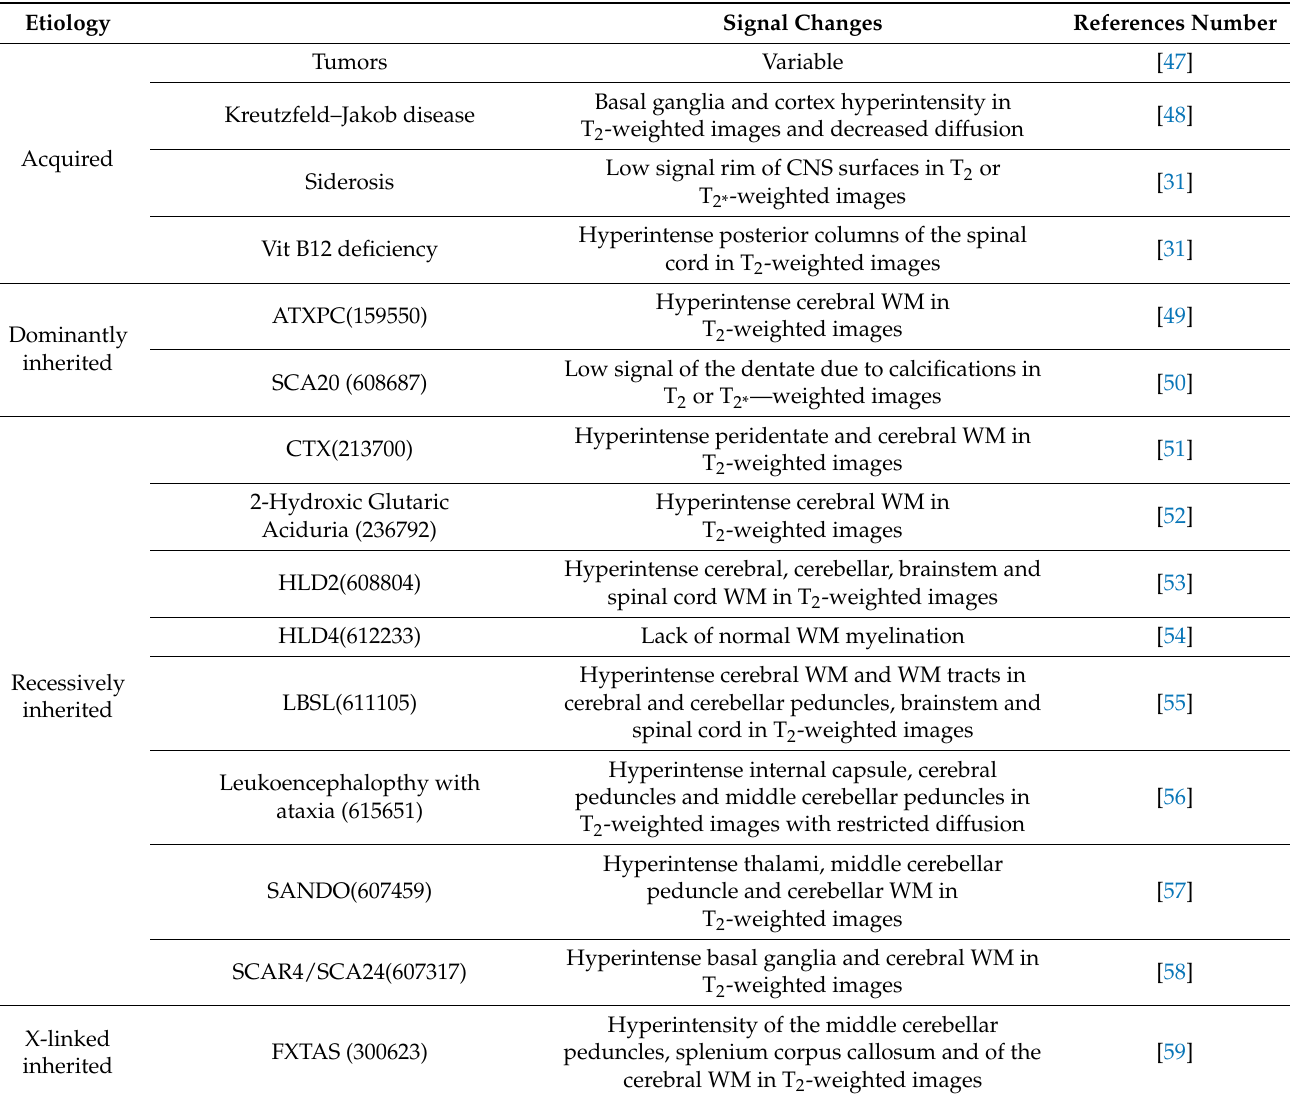
Table 2. Progressive ataxias characterized by predominant MRI signal